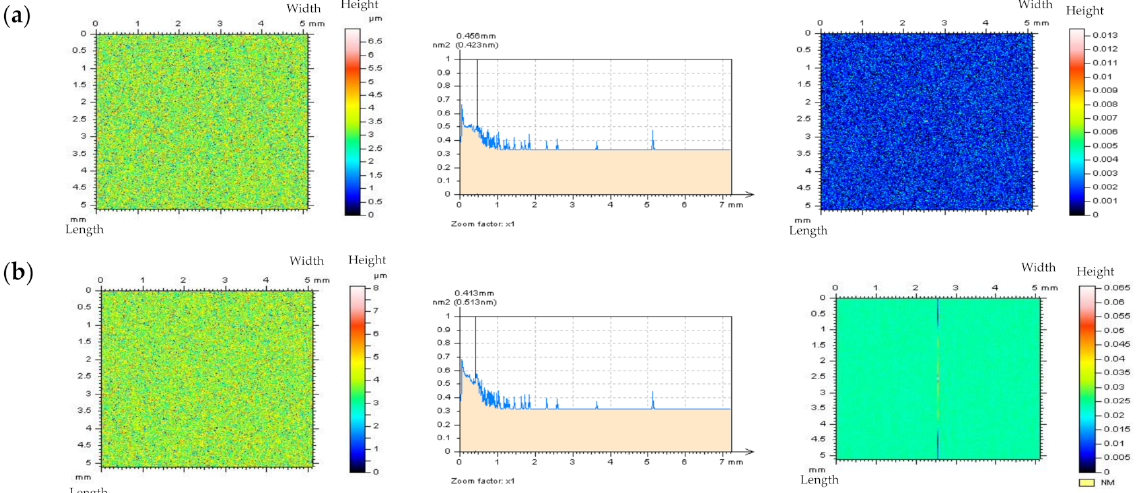
Figure 14. Texture direction graphs of NSs received from the milled surface texture with the application of ( a ) CSSF, ( b ) OPGF, ( c ) OPSF, and ( d ) CSOF.